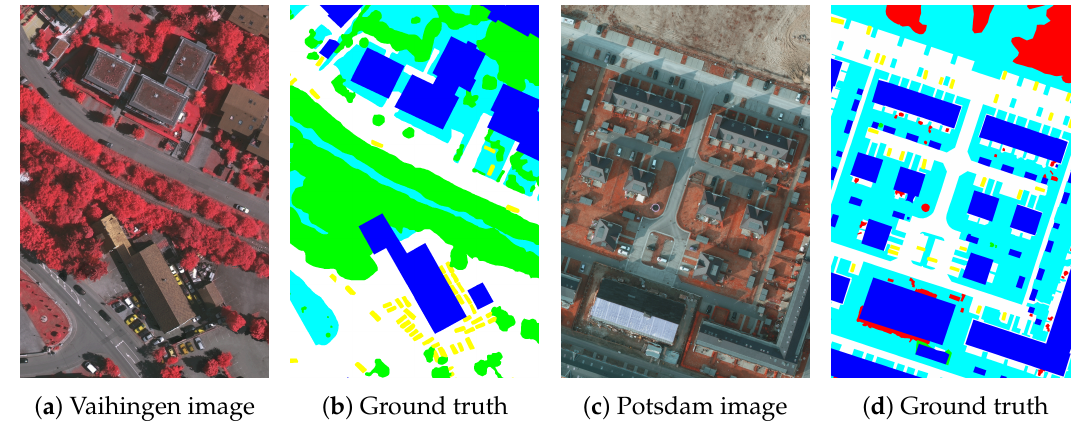
Figure 5. Samples of ISPRS Vaihingen dtaset and Potsdam dataset. There are 5 labeled categories and background (white: impervious surface, blue: building, cyan: low vegetation, green: tree, yellow: car, red: